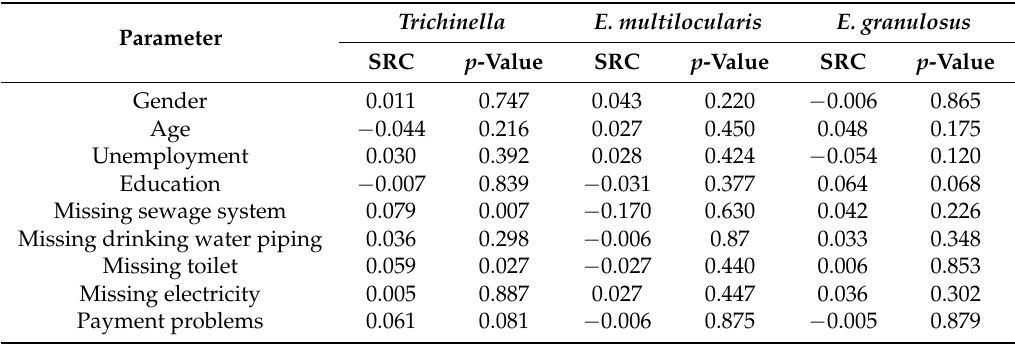
Table 3. Relationship between relative levels of antibodies (OD values) and sociodemographic risk factors in Roma and non-Roma participants of